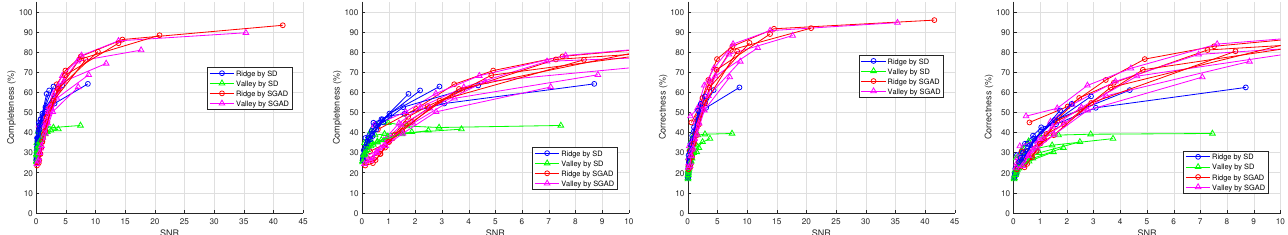
Figure 13. Completeness and correctness against SNR for the Lena image. The second and fourth plots show the zoom-in versions of the first and third plots with SNR range [0, 10],